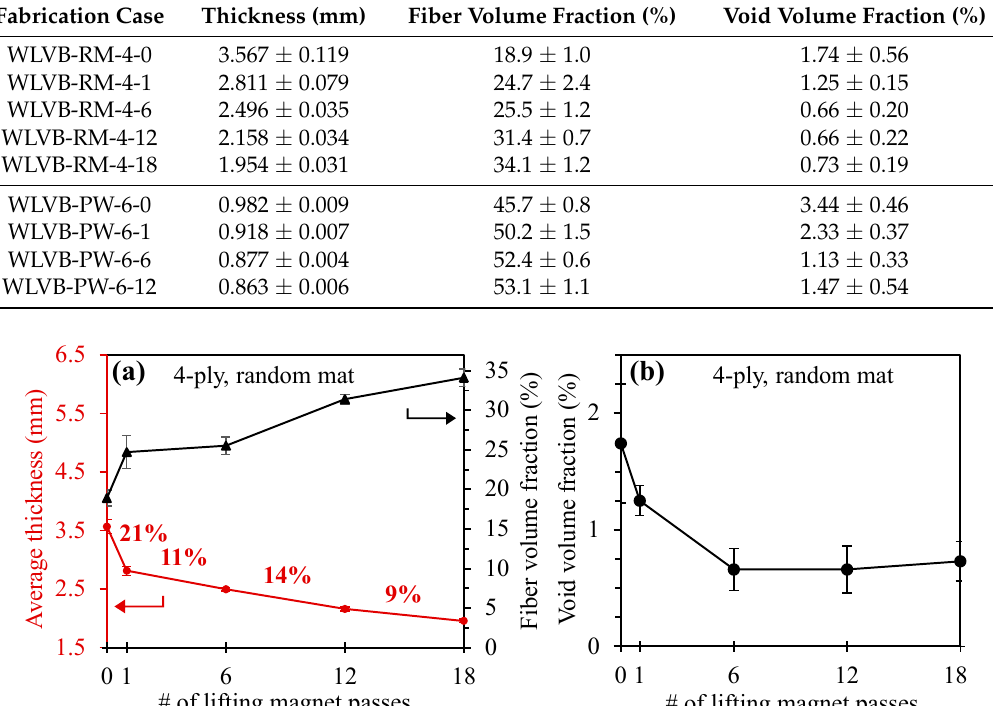
Figure 4. ( a ) Thickness, fiber volume fraction, and ( b ) void volume fraction of random mat laminates fabricated with wet lay-up/vacuum bag (WLVB) and with an increasing number of magnet passes (i.e., 0, 1, 6, 12, and 18 passes). Note: Error bars show the 95% confidence interval ( n = 6 samples for fiber volume fraction and void volume fraction; n = 70 samples for laminate thickness). The percentages shown in ( a ) correspond to the percent thickness reduction between number of passes labeled in the figure.